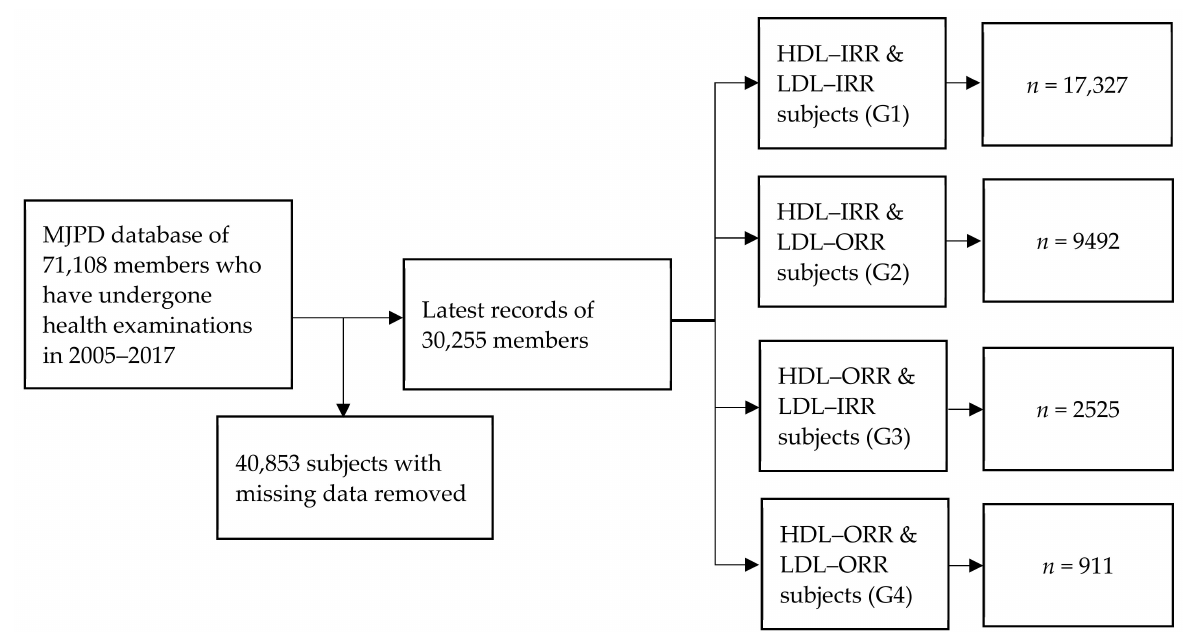
Figure 1. The enrollment flowchart for subject identification. Table 1. Characteristics or laboratory indices of participants for predicting early stage